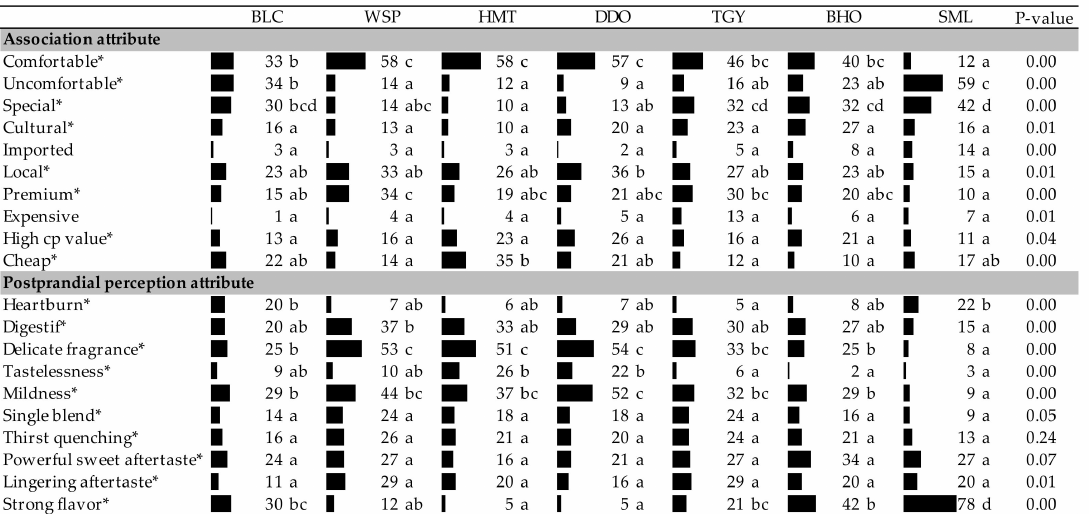
Table 3. Participants’ selection frequencies of association and postprandial perception attributes for the Taiwanese specialty tea infusions based on CATA method ( n =